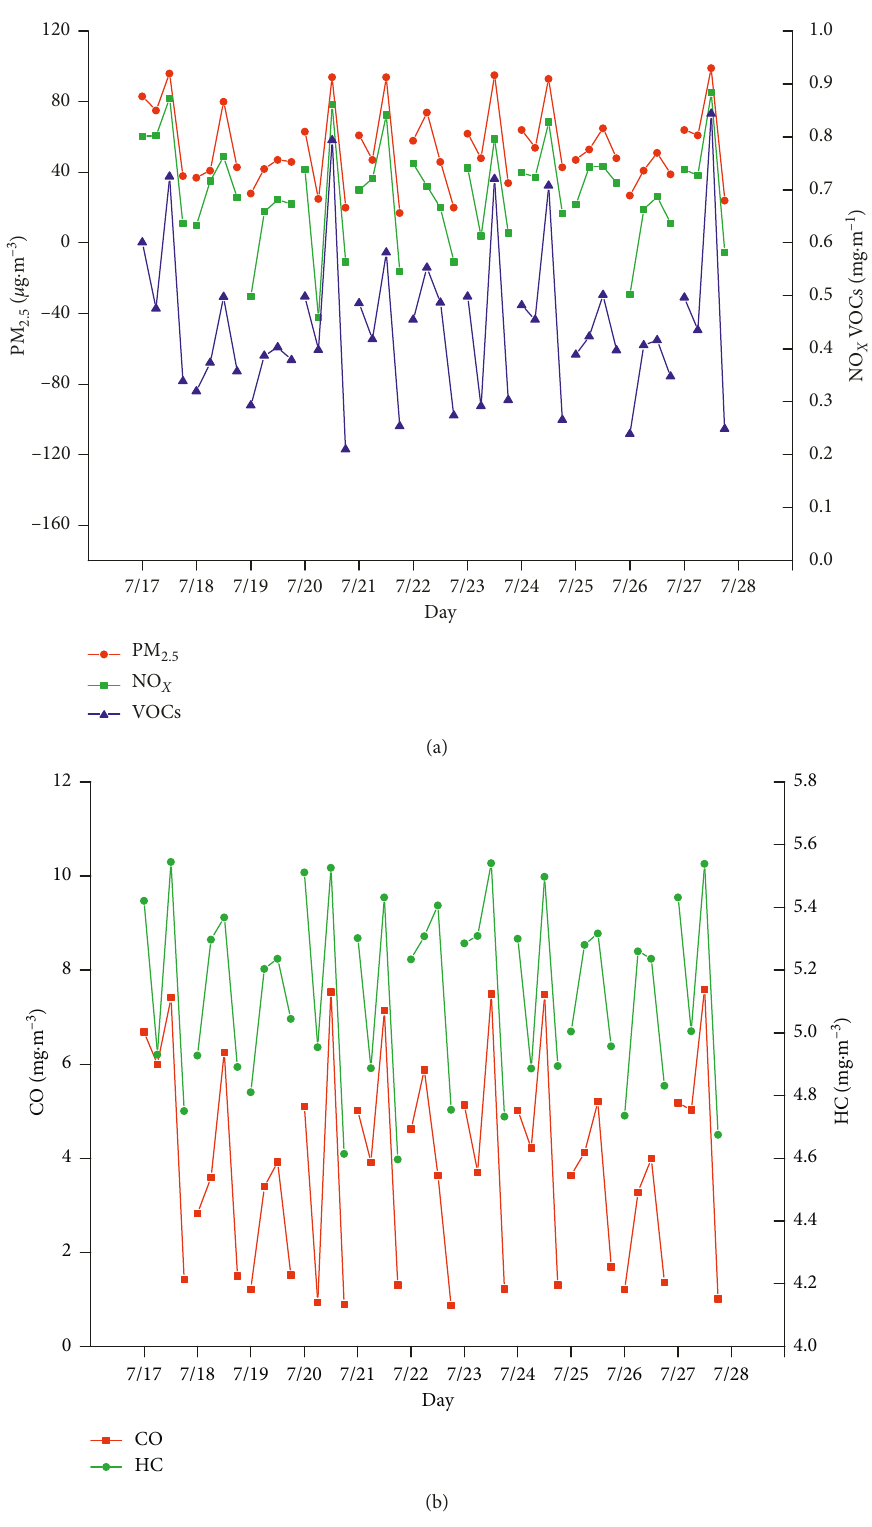
Figure 3: Diurnal variations in five pollutants at site 2 during the sampling period. (a) Diurnal variations in PM VOCs (right axes) for 11 days. (b) Diurnal variations in CO (left axes) and HC (right axes) for 11